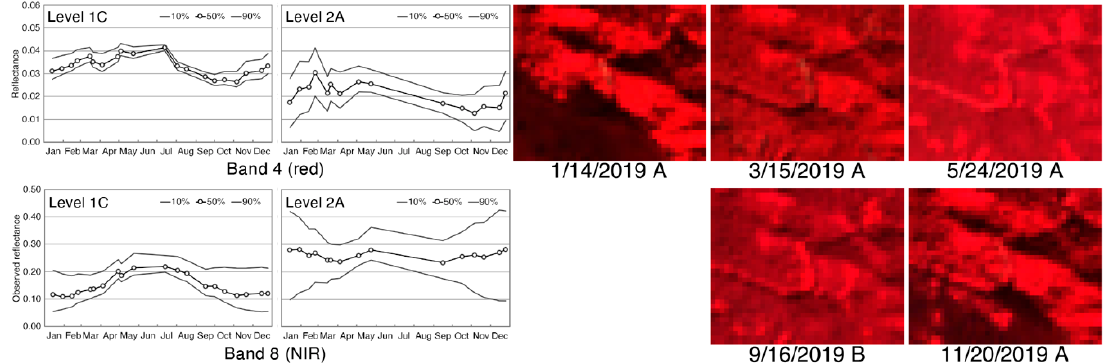
Figure 17. Seasonal profiles of the 10th, 50th, and 90th percentiles of the Sentinel-2 Level-1C and Level-2A product ( left ) and sample images of the Level-2A product ( right ).